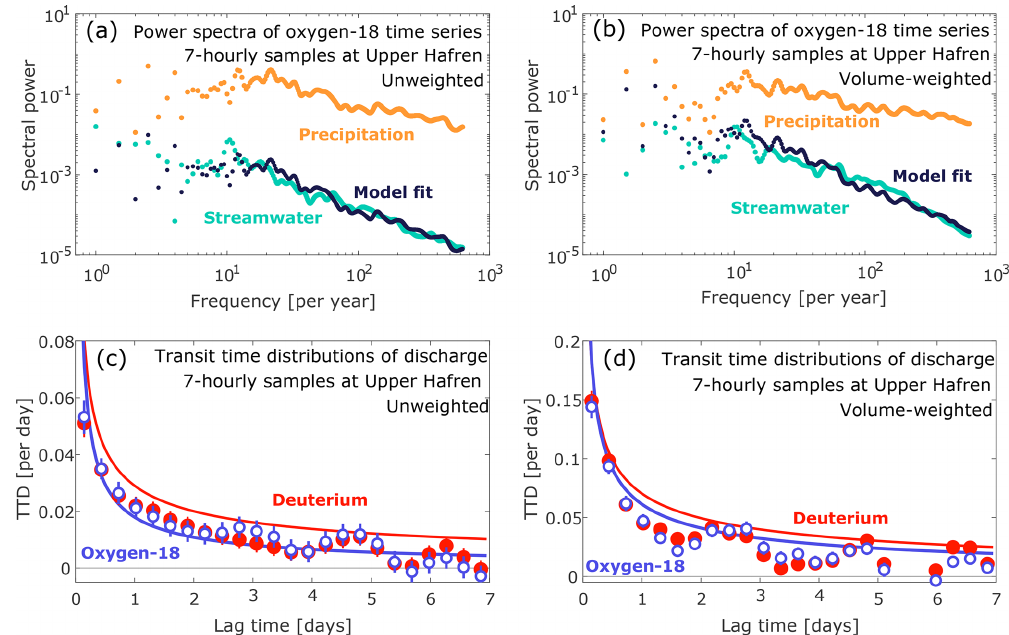
Figure 13. Fits of convolution models to unweighted (a) and volume-weighted (b) power spectra of oxygen-18 in precipitation and streamwa- ter, and gamma distributions estimated by spectral fitting for both deuterium (red lines) and oxygen-18 (blue lines), compared to ensemble hydrograph separation estimates (dots, with standard errors) of unweighted (c) and volume-weighted (d) transit time